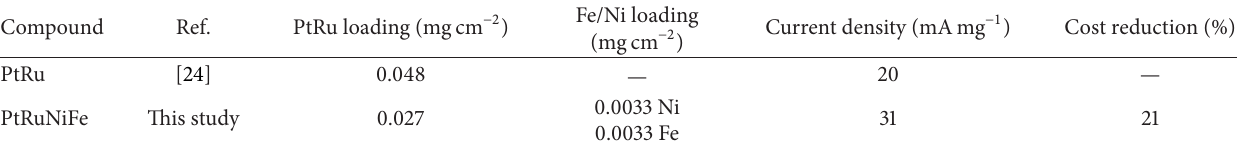
Table 5: Cost reduction.